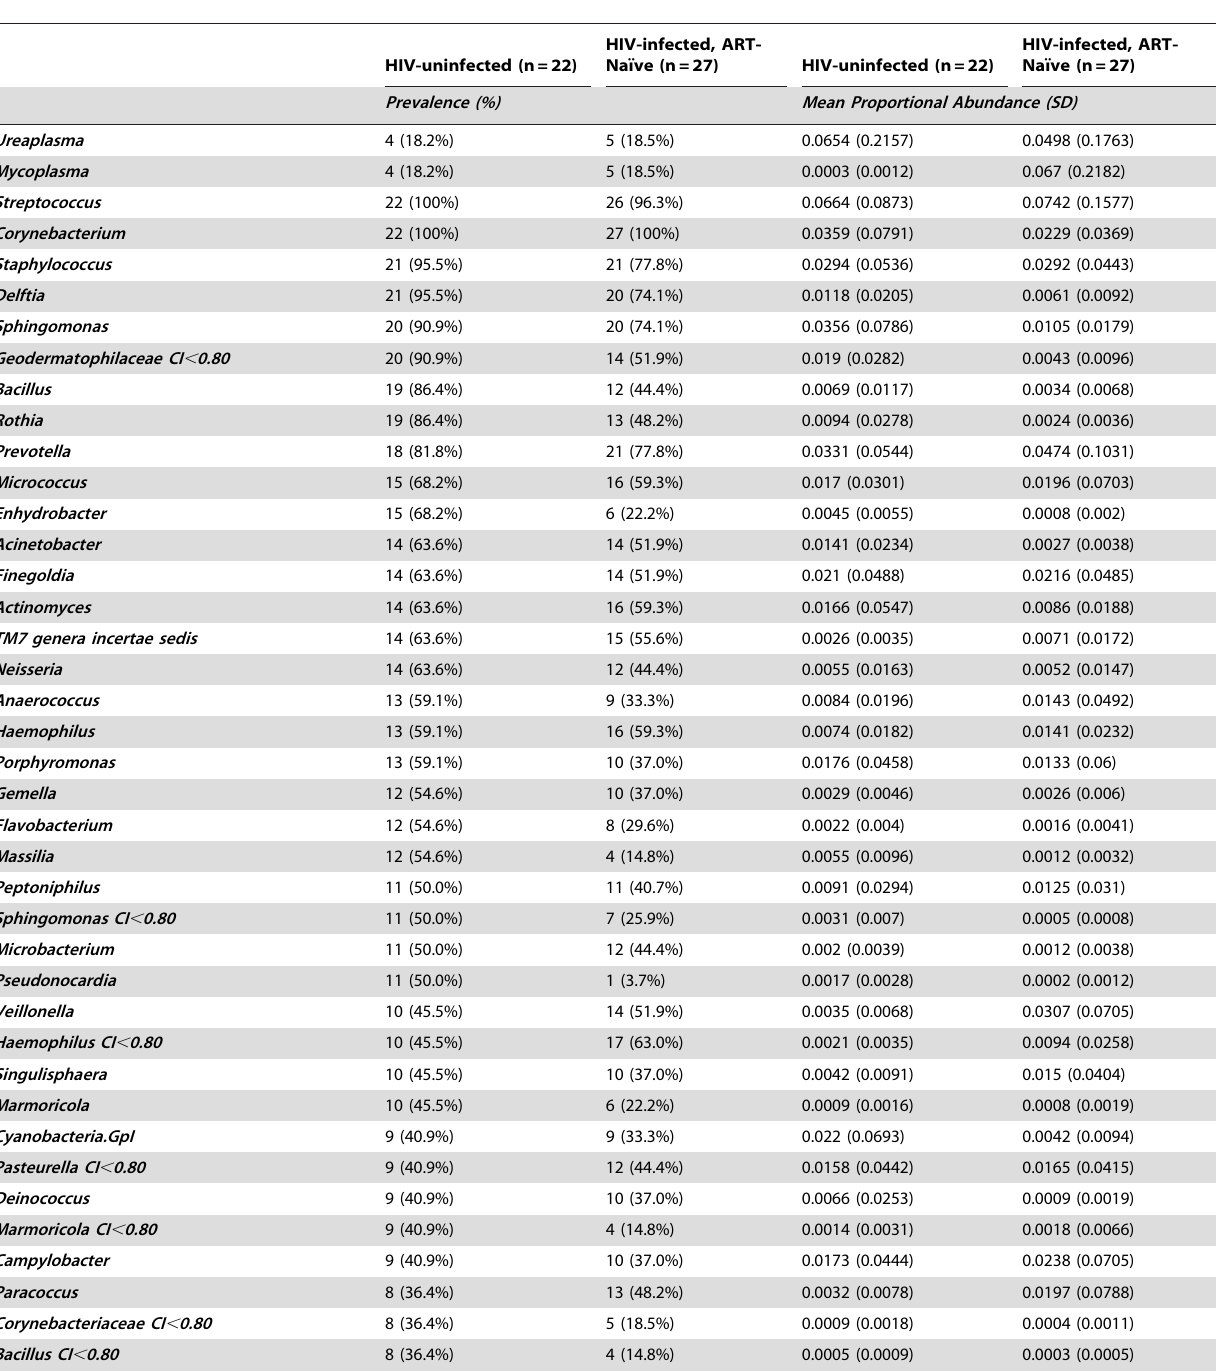
Table 2. Prevalence and proportional abundances of the 40 most prevalent semen bacteria in uninfected men and HIV-infected men prior to initiation of antiretroviral